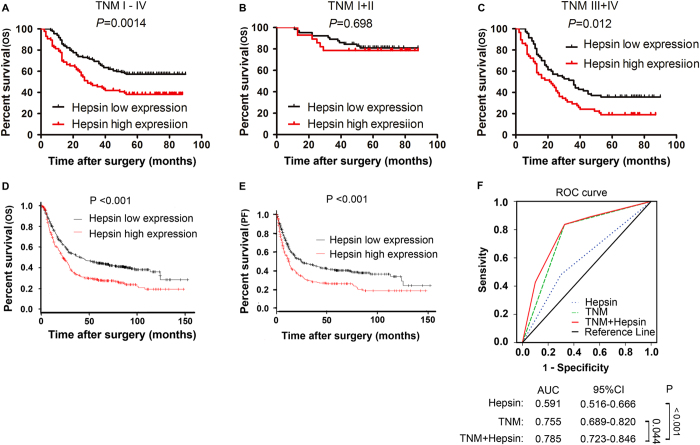
Hepsin expression is correlated with the overall survival rate in gastric cancer patients.(A) Kaplan-Merier survival curves show high expression level of hepsin was significantly correlated with poor survival of gastric cancer. (B,C) Comparisons of overall survival between hepsin high expression and hepsin low expression in early clinical stage (I–II) cohort and in advanced clinical stage (III–IV) cohort. (D,E) The prognostic value of Hepsin in gastric cancer was verified by online survival analysis software (http://www.kmplot.com/analysis/index.php?p=service&cancer=gastric), which integrated reported microarray datasets. It also showed that high expression of Hepsin was significantly associated with poorer overall survival as well as progression-free survival in gastric cancer patients (P < 0.001). (F) ROC analysis of the sensitivity and specificity for the prognosis of overall survival by TNM stage/hepsin expression model, TNM stage model, and hepsin expression model. P-values were calculated by log-rank test.